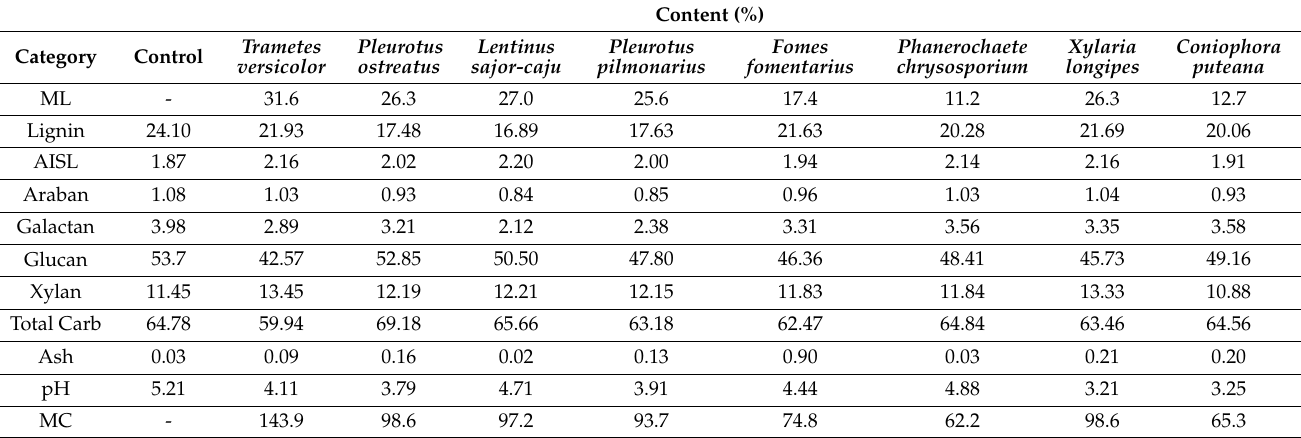
Table 1. Mass loss, wood moisture levels, and chemical contents of beech blocks exposed to selected decay fungi in an EN-113 [34] agar block decay